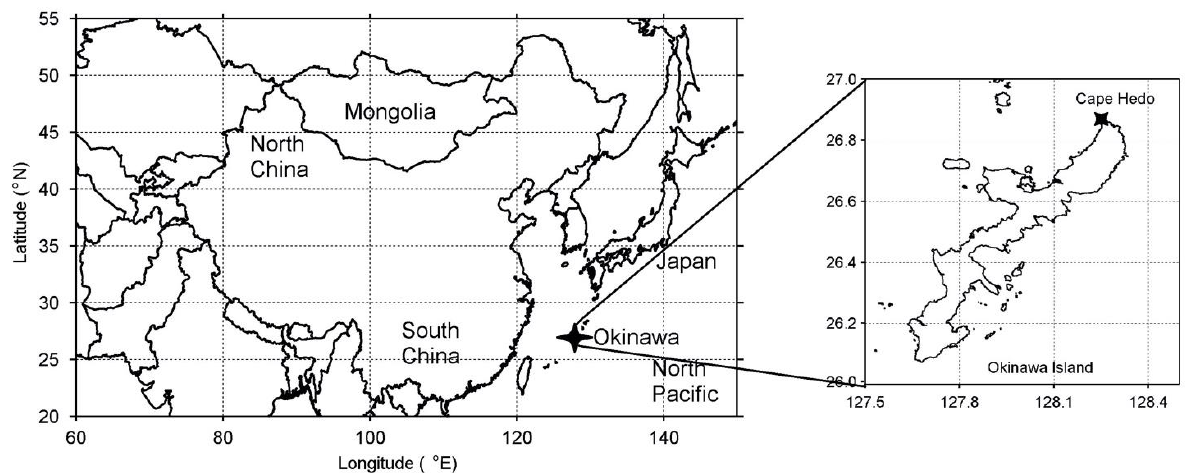
Figure 1. Sampling location, Cape Hedo, Okinawa Island.